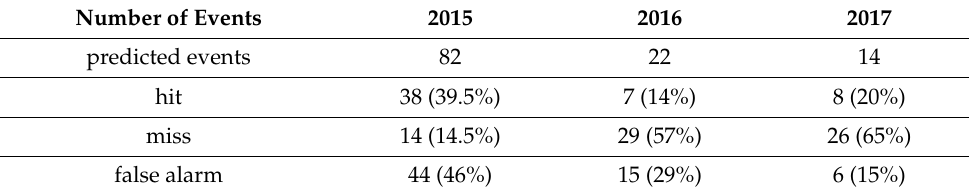
Table 2. Numbers of the hit, miss and false alarm events predicted by the SMDC system in 2015–2017. The number of the predicted events corresponds to the sum of the hit and false alarm events from Table 1. obtained after the Step 4 filter. The percentage of the number of hits, misses and false alarms to the sum of all three values is indicated in